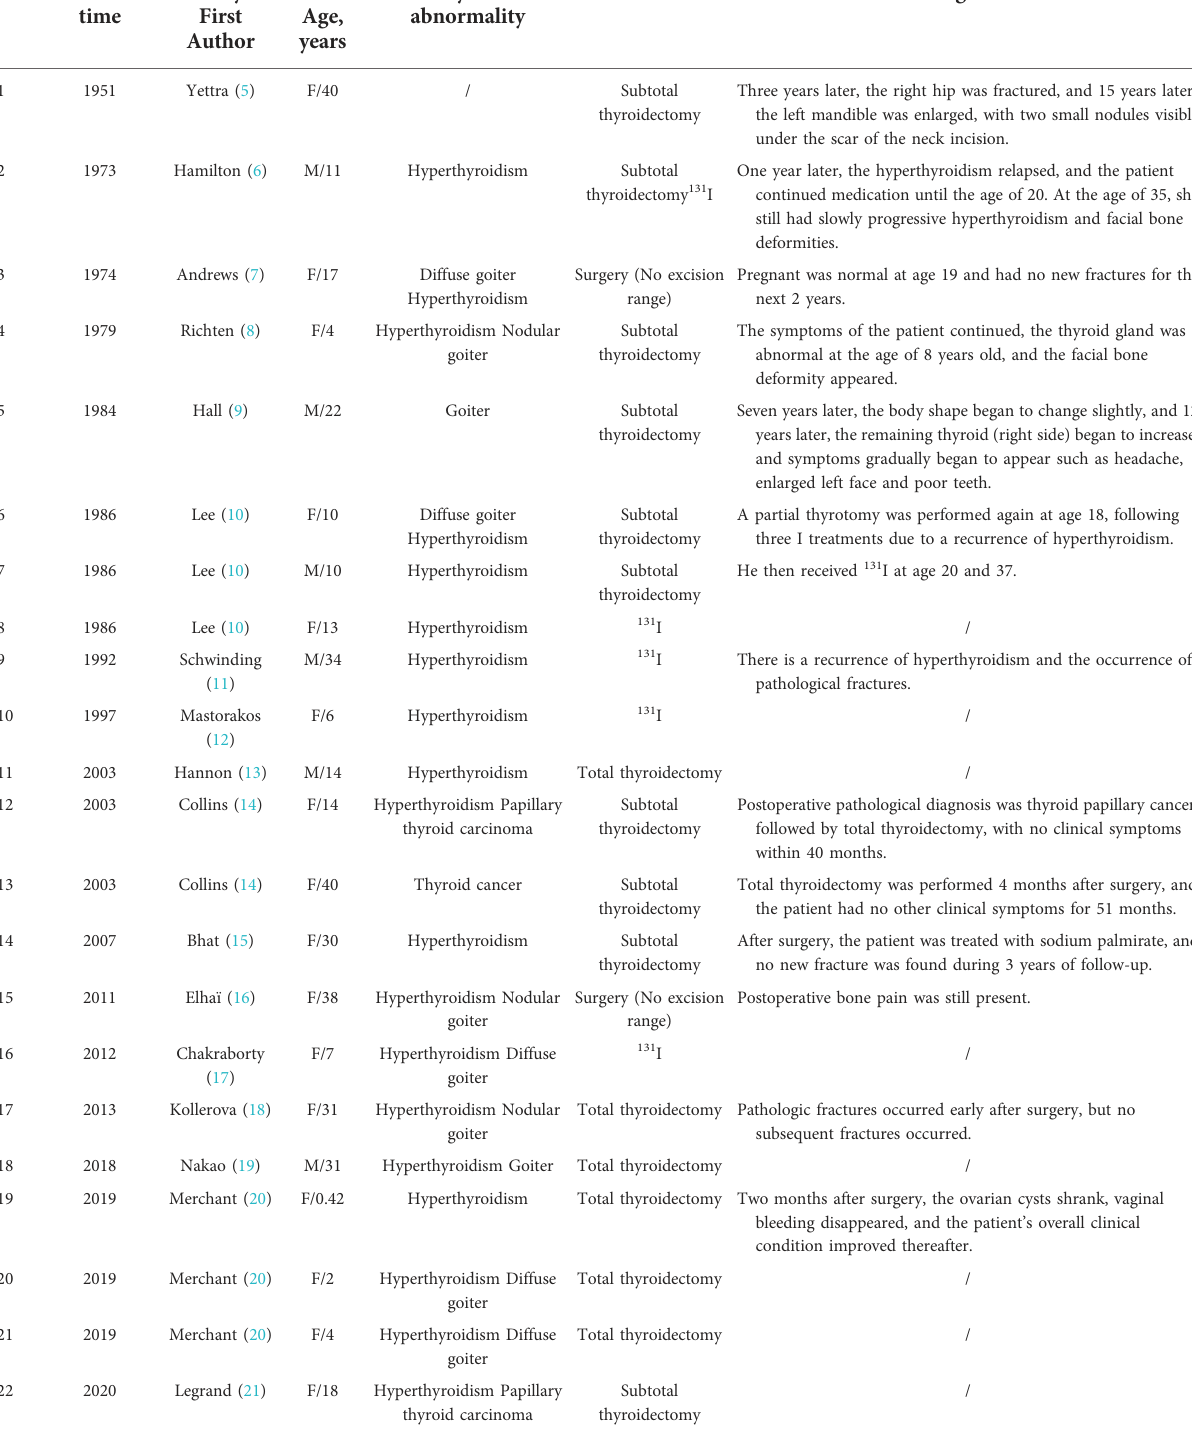
TABLE 1 Characteristics, treatments, and prognoses of reported MAS with thyroid